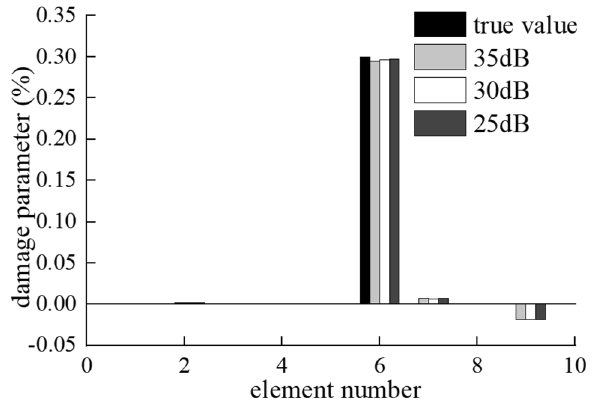
Figure 5. Result of damage identification in single damage case on the smooth road surface.